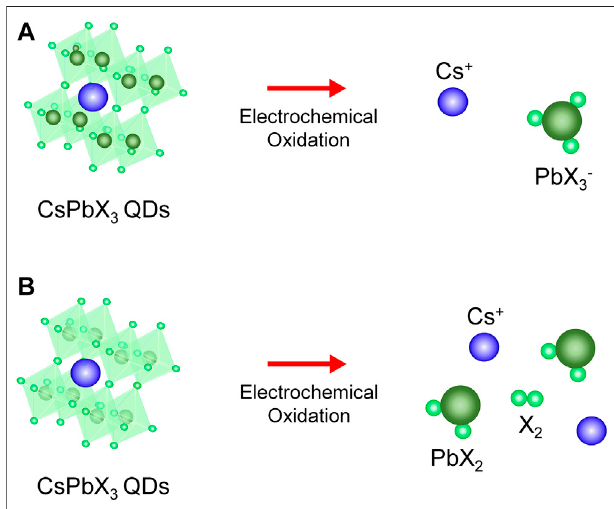
FIGURE 5 | (A,B) Schematic illustrating the proposed reaction mechanism for the irreversible transformation for CsPbBr 3 and CsPbI 3 PQDs.